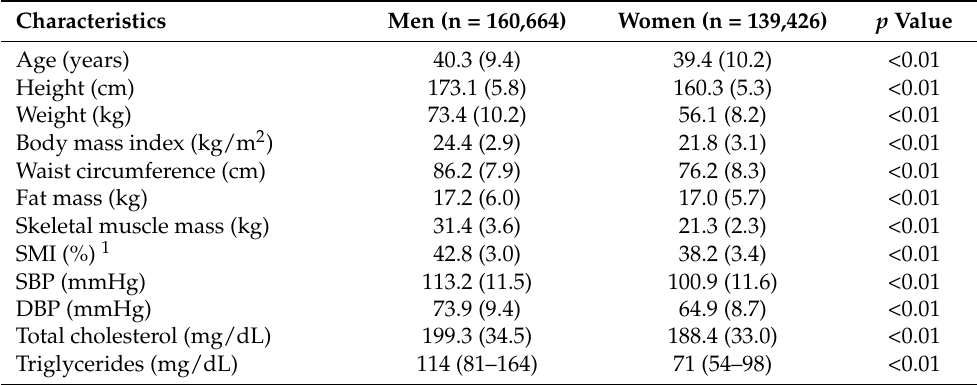
Table 1. Basic characteristics and age distribution of men and women in study subjects ( n = 300,090).